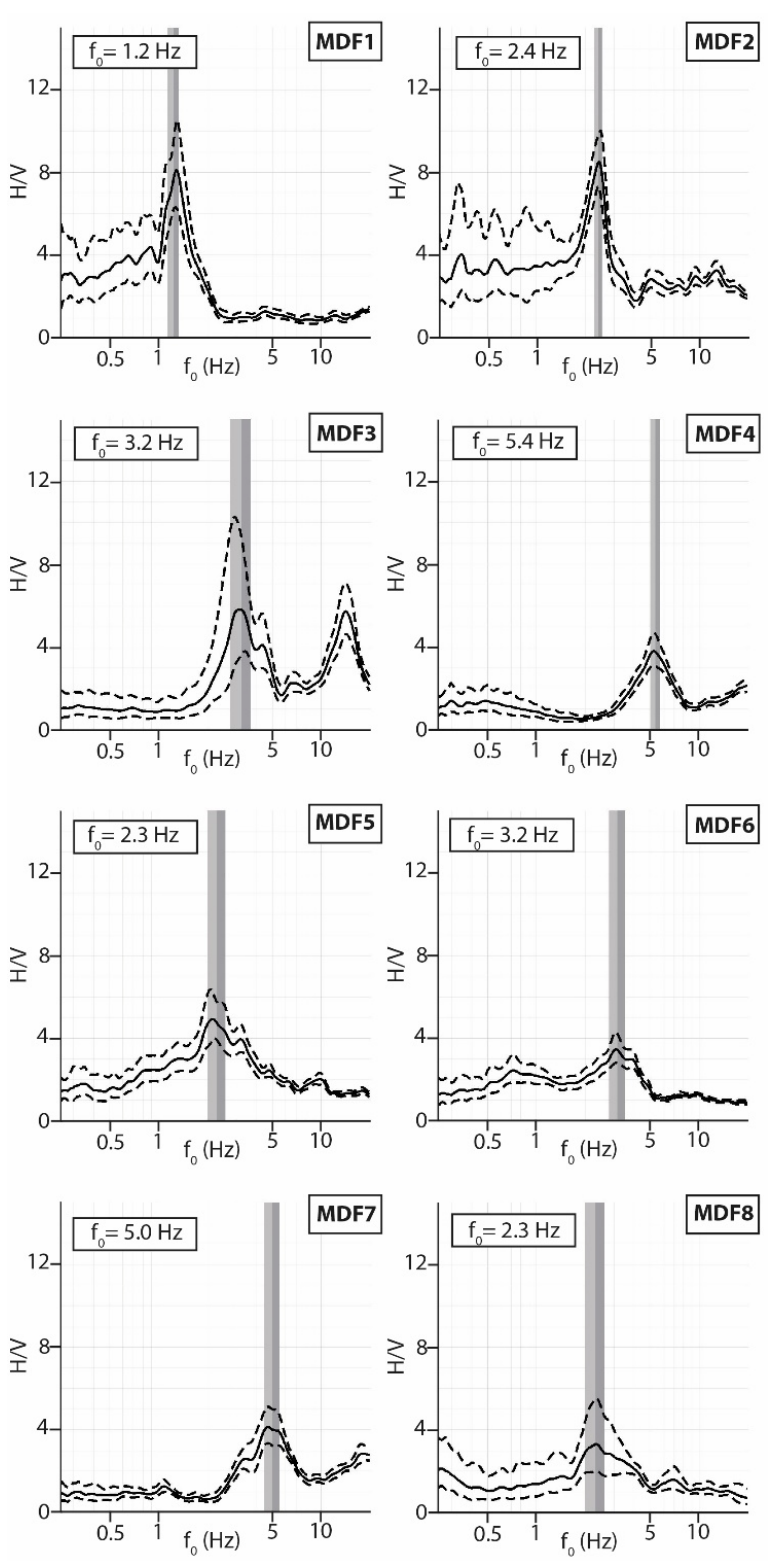
Figure 7. Mean noise HVSRs (thick lines) and standard deviation curves (dashed lines) at the MDF1-8 sites. It must be noted that the MDF1 measurement was acquired in the MDF site which is the location with the lowest resonance frequency (around 1.2 Hz) obtained. For the location of the measurements, please check Figure 5.